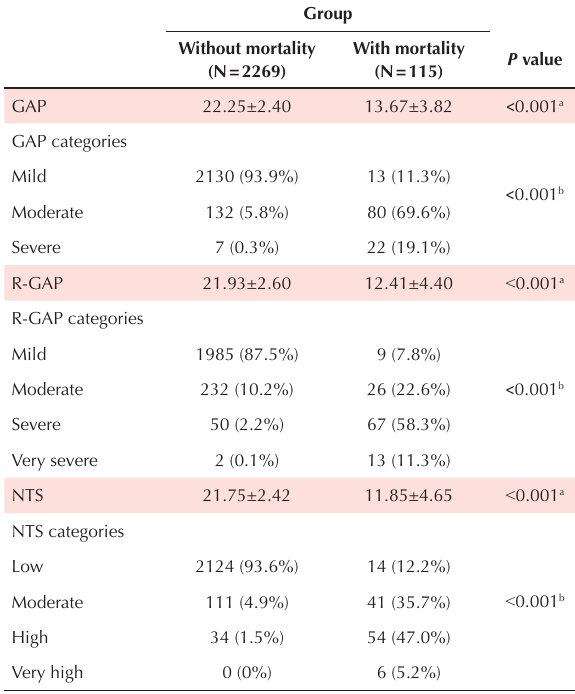
Table 2. Comparison of the characteristic features, and vital signs between the two groups based on hospital outcome Table 3. Comparison of three trauma scores (GAP, R-GAP, and NTS) between Group the two groups of patients